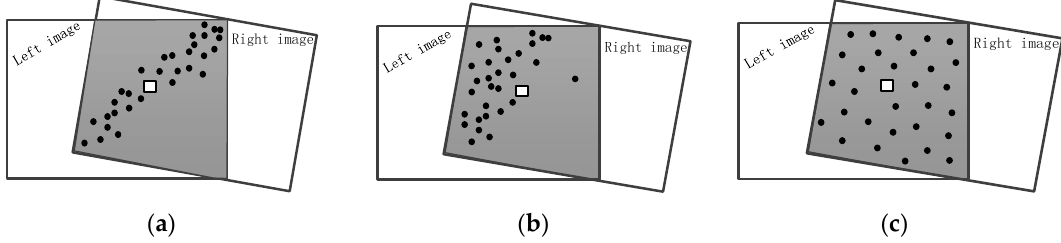
Figure 1. Distribution of matching points. ( a ) Linearly distributed matching points. ( b ) Clustered distributed matching points. ( c ) Evenly distributed matching points.